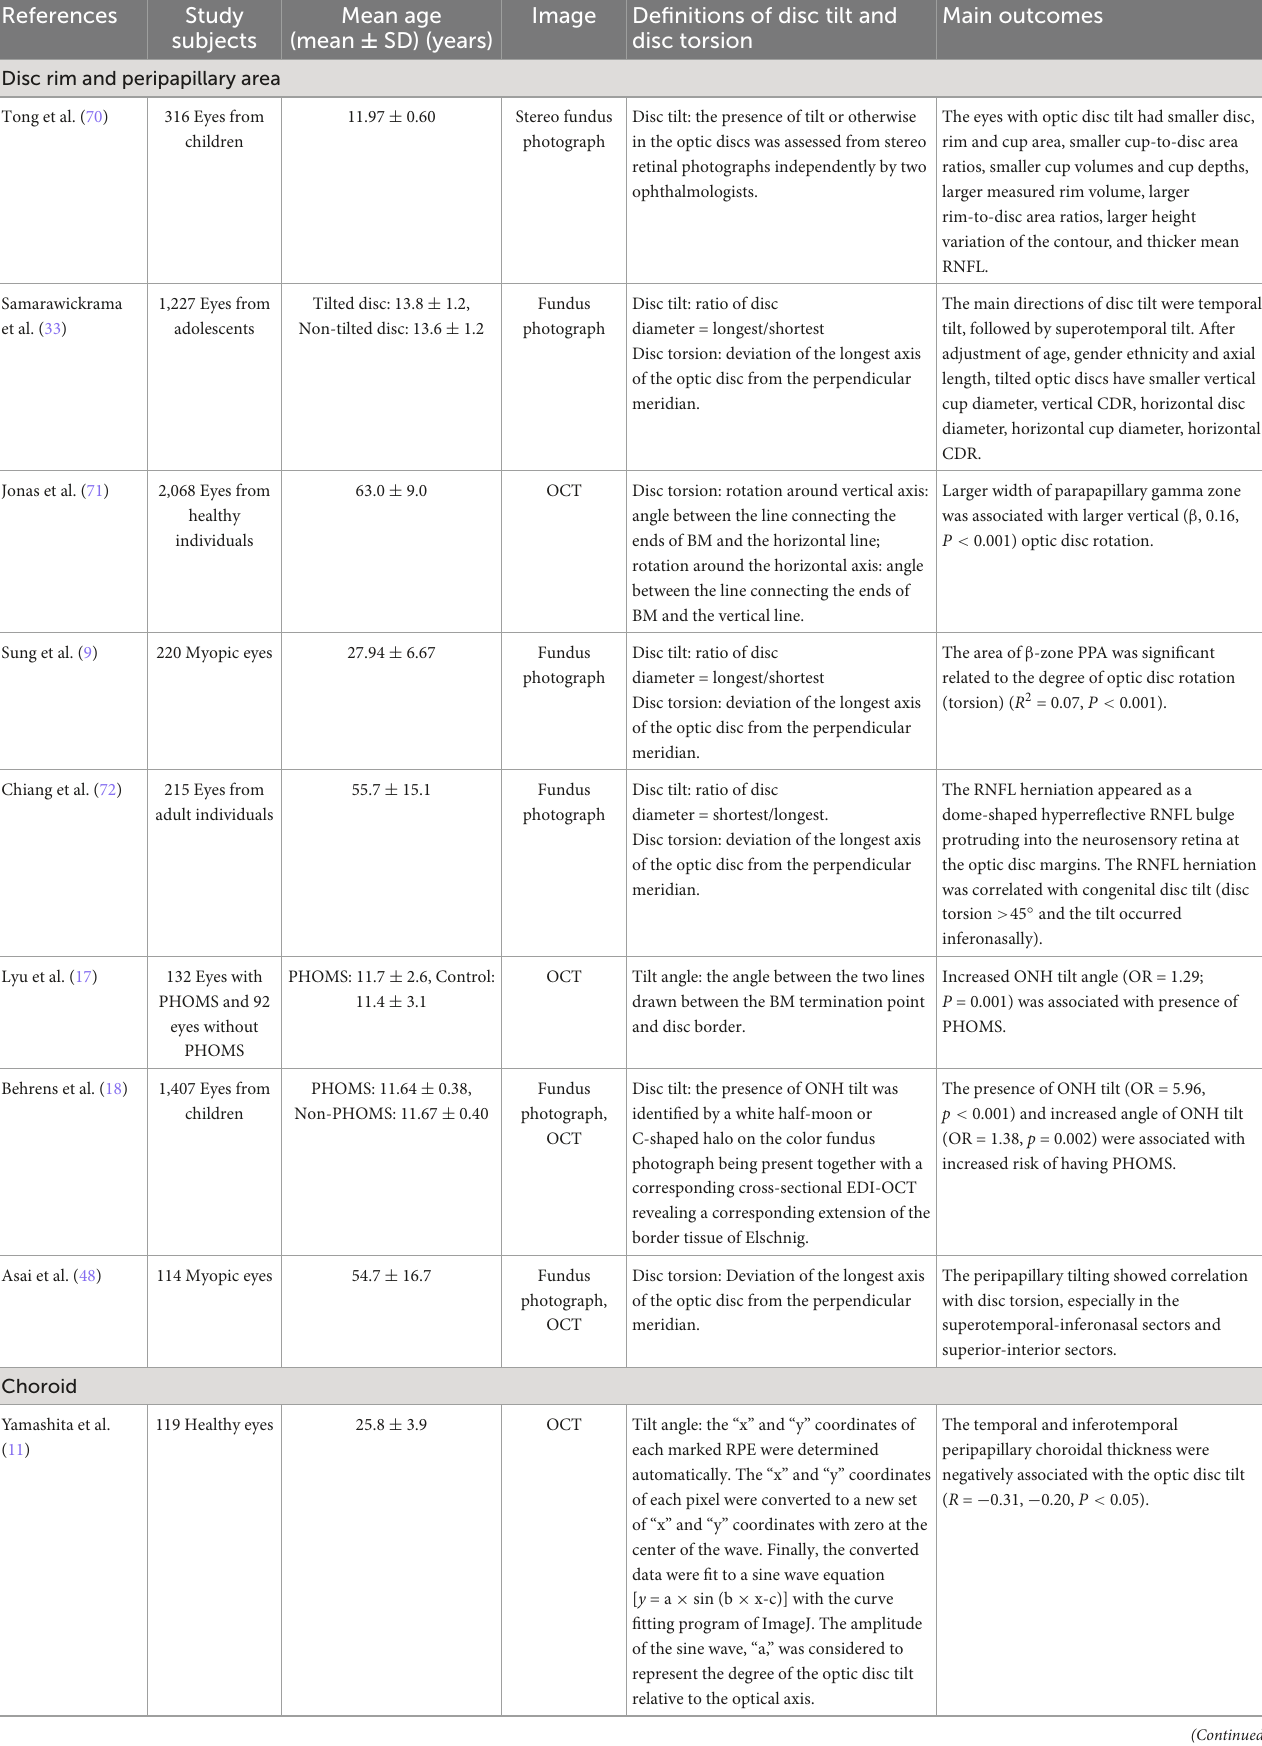
TABLE 2B Change of optic nerve head, lamina cribrosa, sclera, choroid, and microvasculature in related to myopic tilted disc in myopic